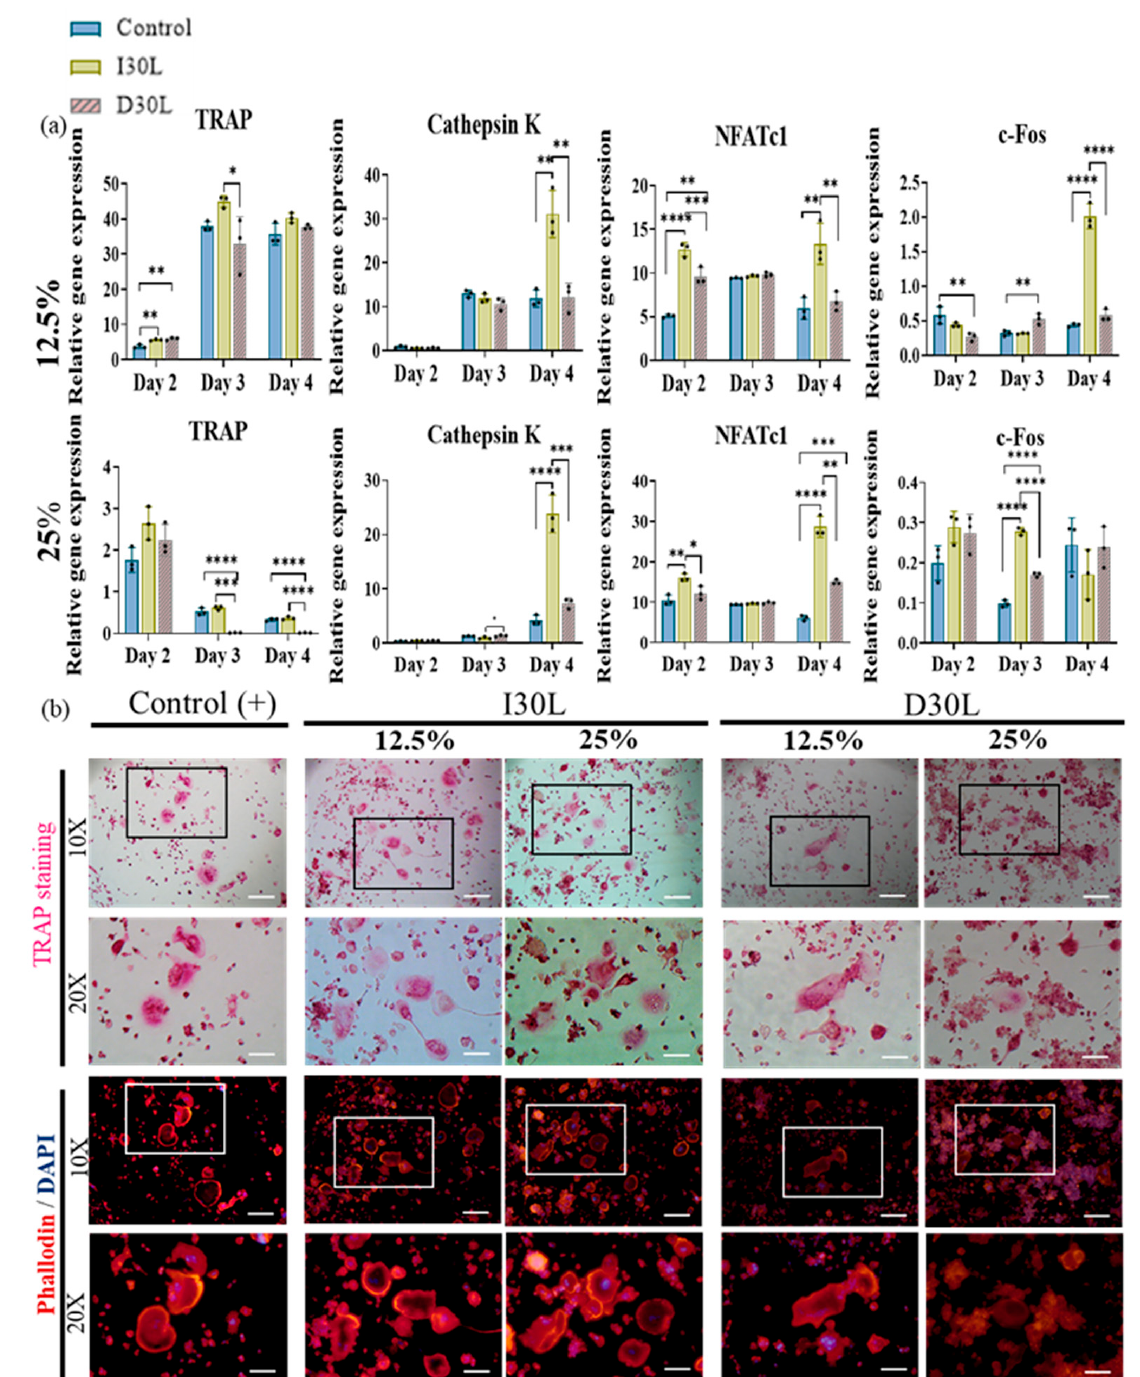
Figure 5. Osteoclast differentiation test of NaI-based paste using extract compared to iodoform-based paste. ( a ) RAW 264.7 cells were differentiated into osteoclasts in 12.5% and 25% nontoxic extracts from culture media. After 2, 3, and 4 days of culture, the gene expression of c-FOS, NFATc1, cathepsin K, and TRAP were measured by qPCR. * represents p < 0.05, ** p < 0.01, *** p < 0.001, **** p < 0.0001, n = 3. ( b ) Representative images of TRAP and phalloidin & DAPI staining of osteoclasts from one of the three experiments are shown. The scale bar is written and the 10 × -scale bar is 200 µ m and the 20 × -scale bar is 100 µ m. TRAP staining showed the highest number of differentiated osteoclasts in I30L and the lowest in D30L. The size of the actin ring increased in